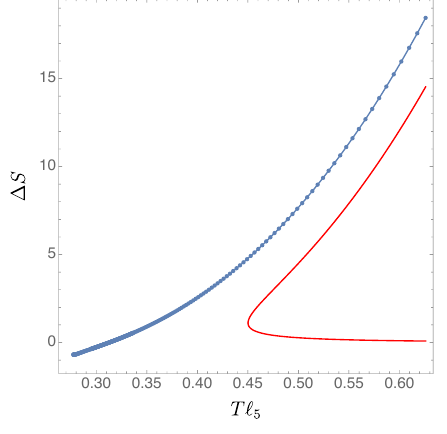
Figure 11 . Comparing (cid:1) S for a fat funnel with the entropy of a spherical Schwarzschild-AdS 5 black hole at the same temperature: the solid red line corresponds to the Schwarzschild-AdS 5 black hole, and the blue disks to the fat funnel phase. Both phases exhibit a power law behaviour at large values of T‘ 5